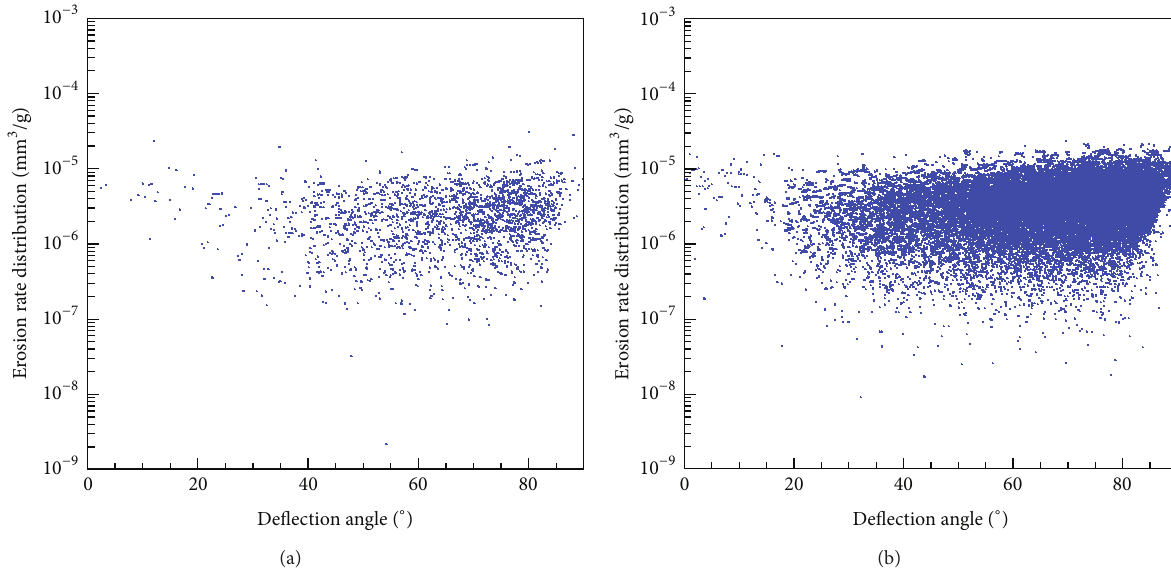
Figure 7: Erosion rate 𝐸 V distribution per impact particle against the deflection angle of curved duct at the inlet velocity 5.3m/s: (a) particle diameter 3 𝜇 m and (b) particle diameter 1 𝜇